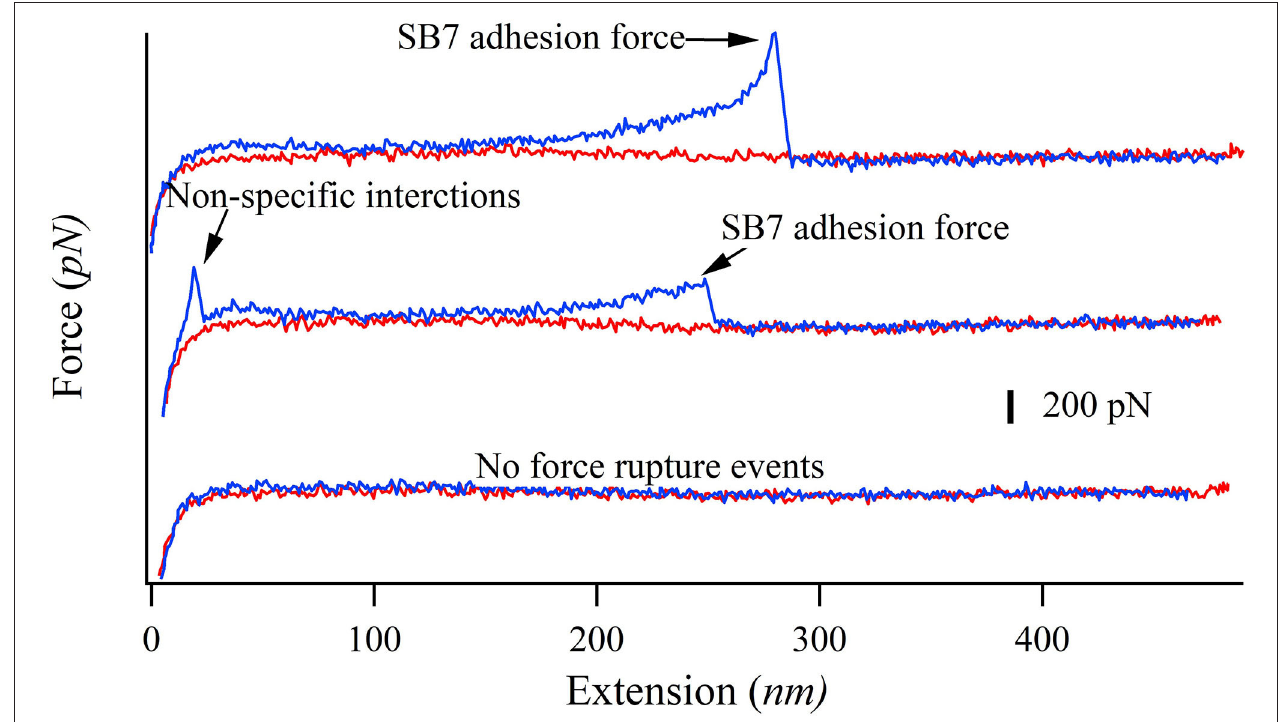
FIGURE 2 | Representative force-extension curves of pulling SB7 from glass surface. The approaching and pulling curves are colored in red and blue, respectively. Top curve: single-molecule SB7 adhesion. Middle curve: single-molecule SB7 adhesion with non-specific interactions. Bottom curve: no force rupture events.